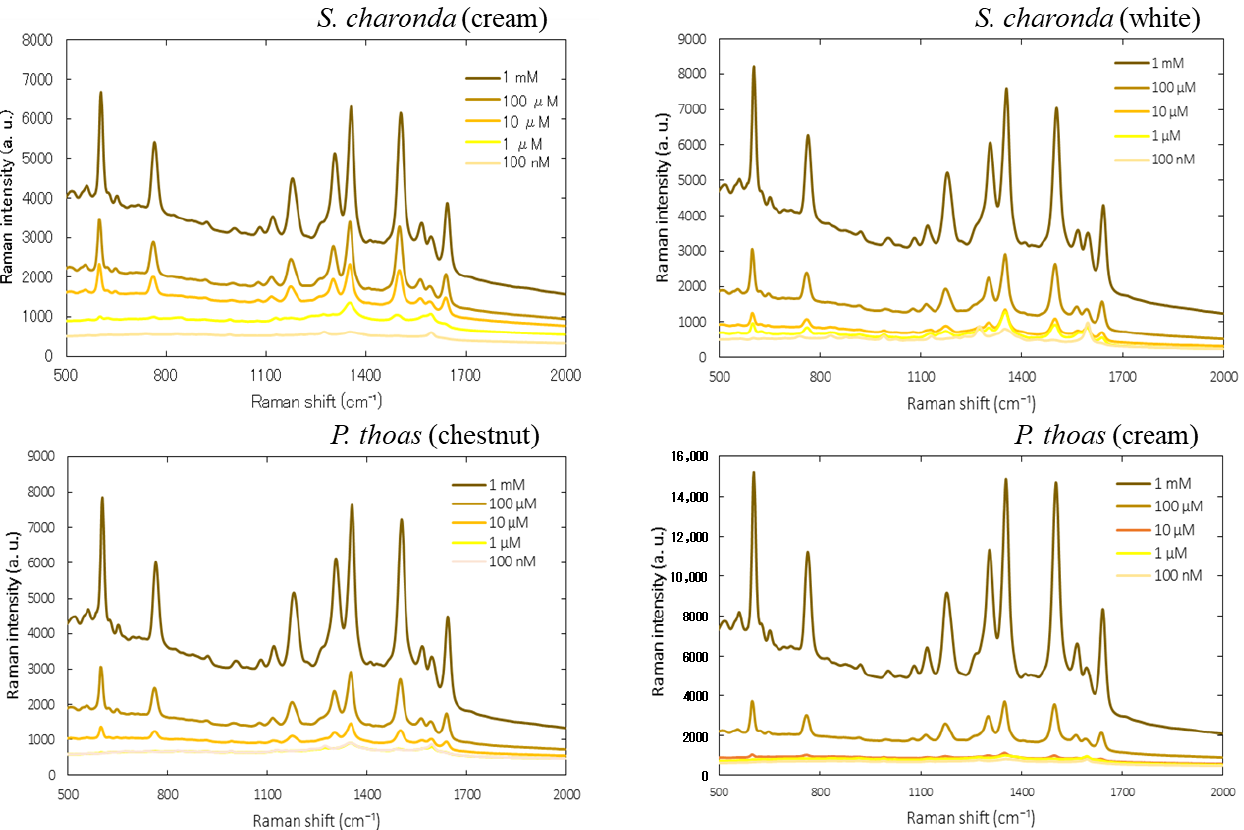
Figure A6. R6G SERS spectra with different R6G concentrations (1 mM, 100 µM, 10 µM, 1 µM, and 100 nM) from cream and white scales of S. charonda , and chestnut and cream scales from P. thoas .